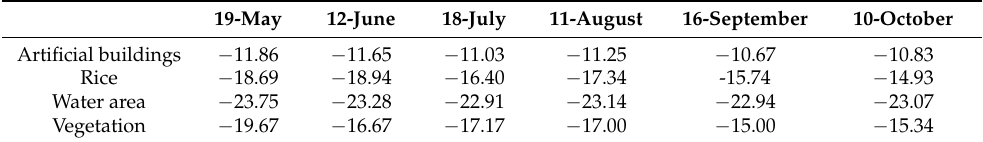
Figure 16. Sentinel-1 VH polarization backscatter coefficient of ground objects. Table 6. VH polarization backscatter coefficient of ground objects.